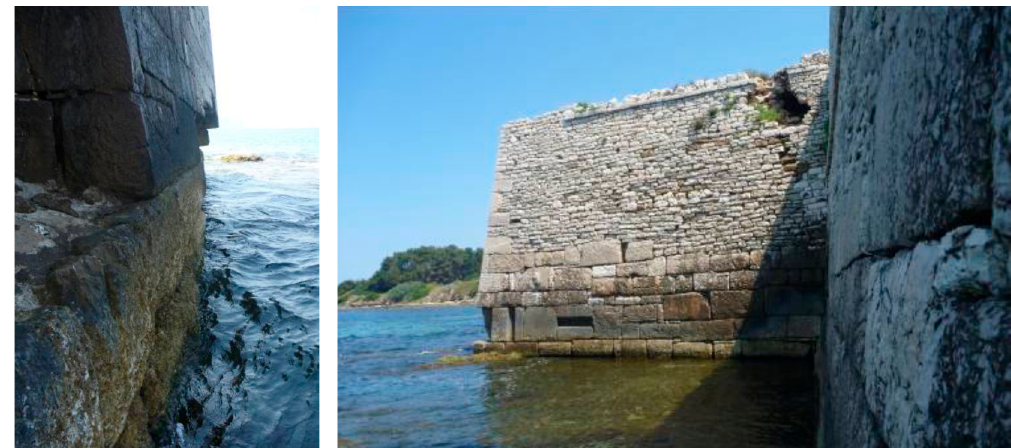
Figure 5. Combined decay: seismic effects, salt weathering in coastal areas, vegetation growth, and different construction phases over centuries. Extreme corrosion of all stones undergoing wetting and drying. The Castle of Preveza, Greece, June 2017.